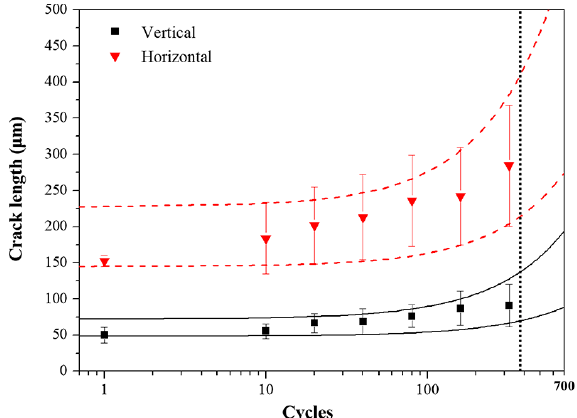
Figure 8. Variation of crack length on the cross section during CTF tests. Dotted and solid curves indicate empirical data fits for the horizontal and vertical cracks, respectively. The dotted vertical line is the failure cycles of TBCs with cracks formed by 30 N.